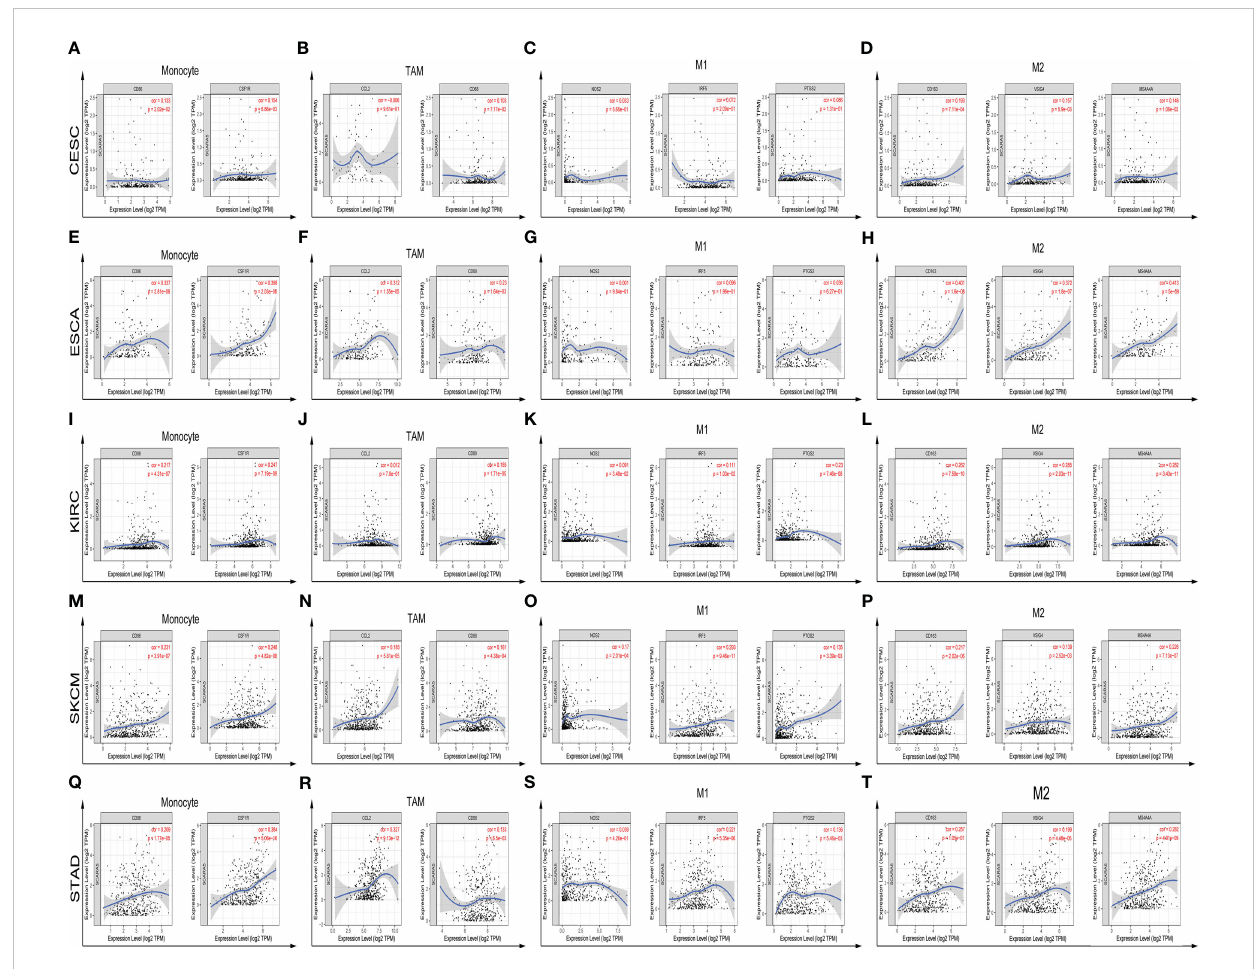
FIGURE 7 Further analysis of immune in fi ltration correlations with statistical signi fi cance in CESC, ESCA, KIRC, SKCM, STAD, and speci fi c immune molecules (CD86, CSF1R, CCL2, CD68, NOS2, IRF5, PTGS2, CD163, VSIG4, and MS4A4A) (A – T)